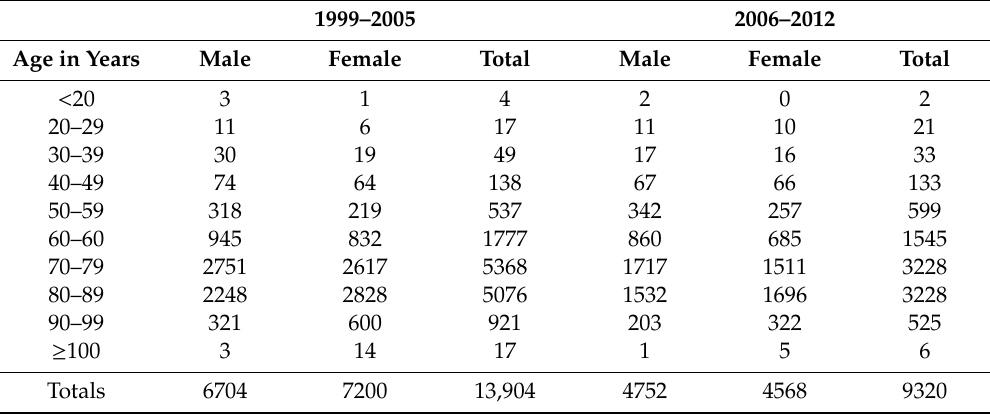
Table 3. Louisiana hospital primary PD discharges by age and